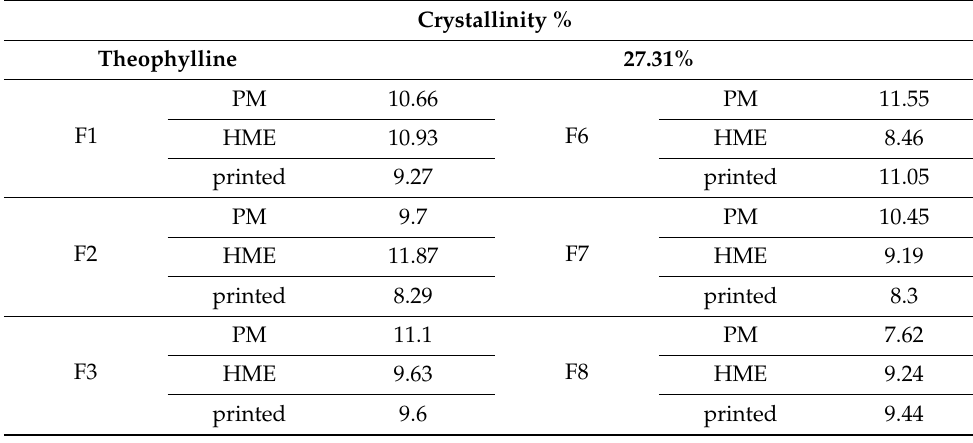
Table 2. Crystallinity % values in all formulations prepared by the three methods.